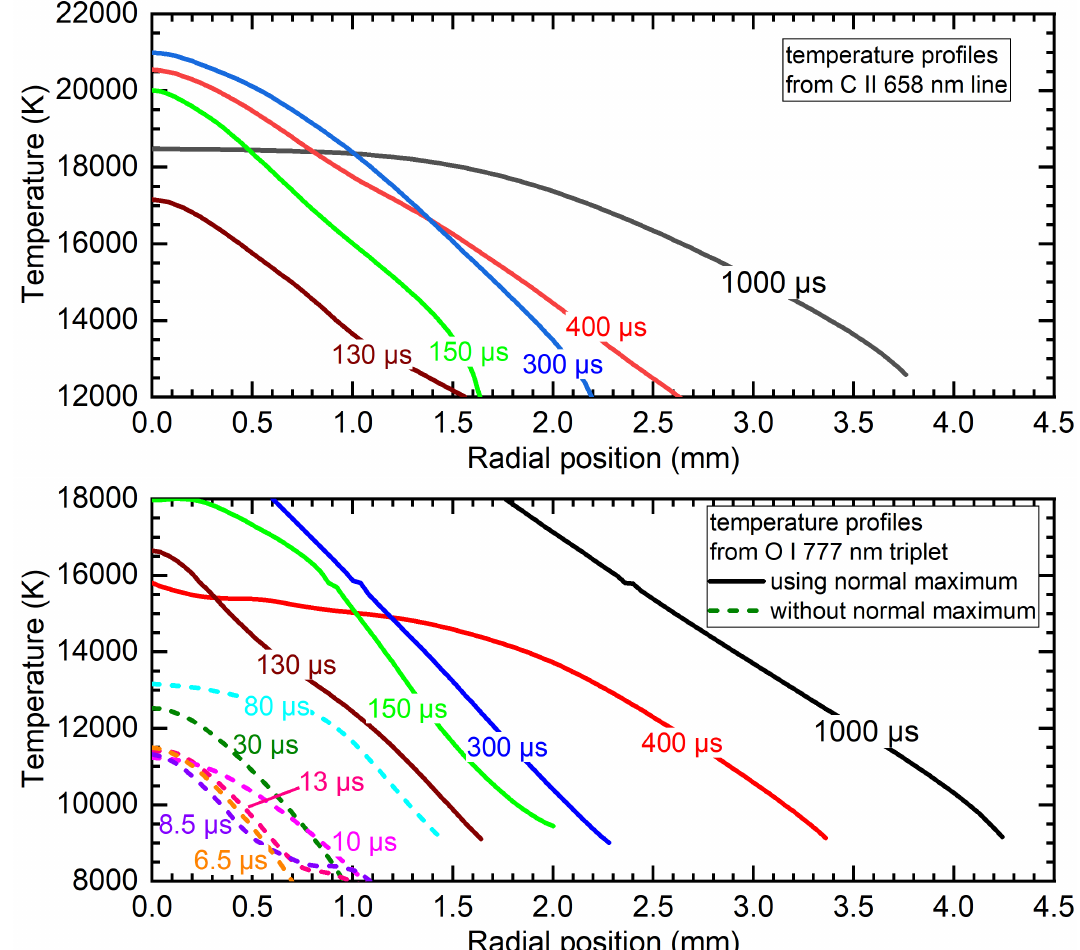
Figure 10. Radial profiles of plasma temperature obtained from ionic carbon line C II at 658nm ( top ) and from atomic oxygen triplet at 777nm ( bottom ) with (130–1000 µ s) and without (<100 µ s before CZ, dashed curves) application of normal